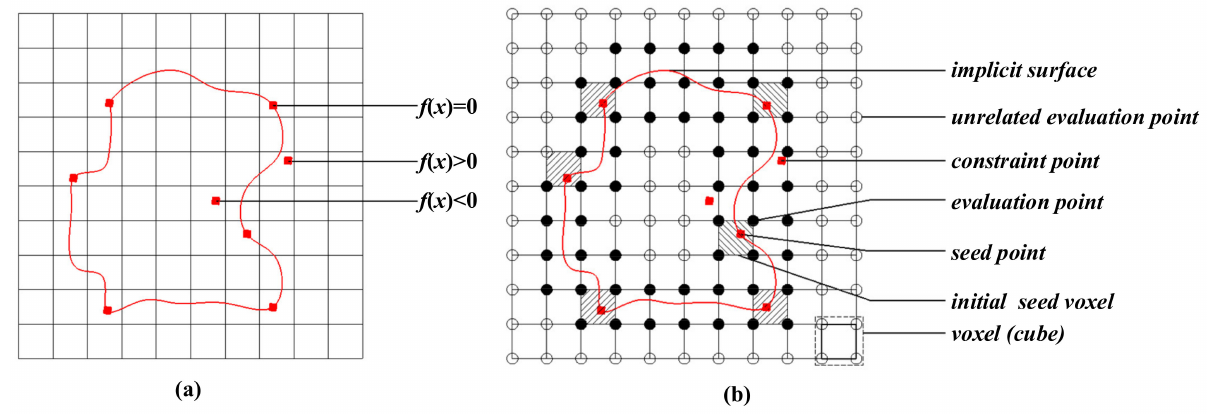
Figure 1. The voxel growing method with multiple seed points. ( a ) The zero-level set represents the implicit surface. ( b ) The initial seed voxels are selected from the interpolation constraints with zero